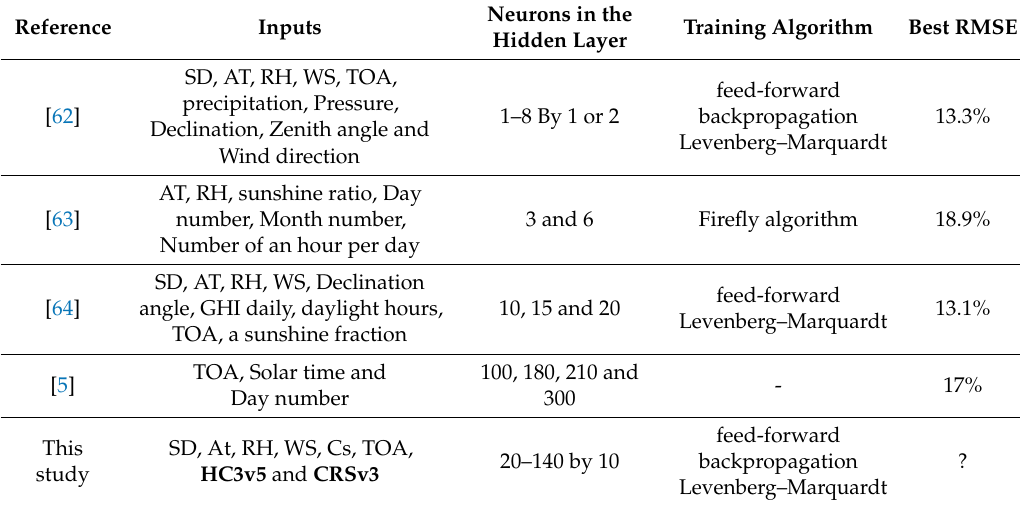
Table 1. The literature for estimating Global Horizontal Irradiance (GHI) with Artificial Neural Networks (ANN) models on hourly time